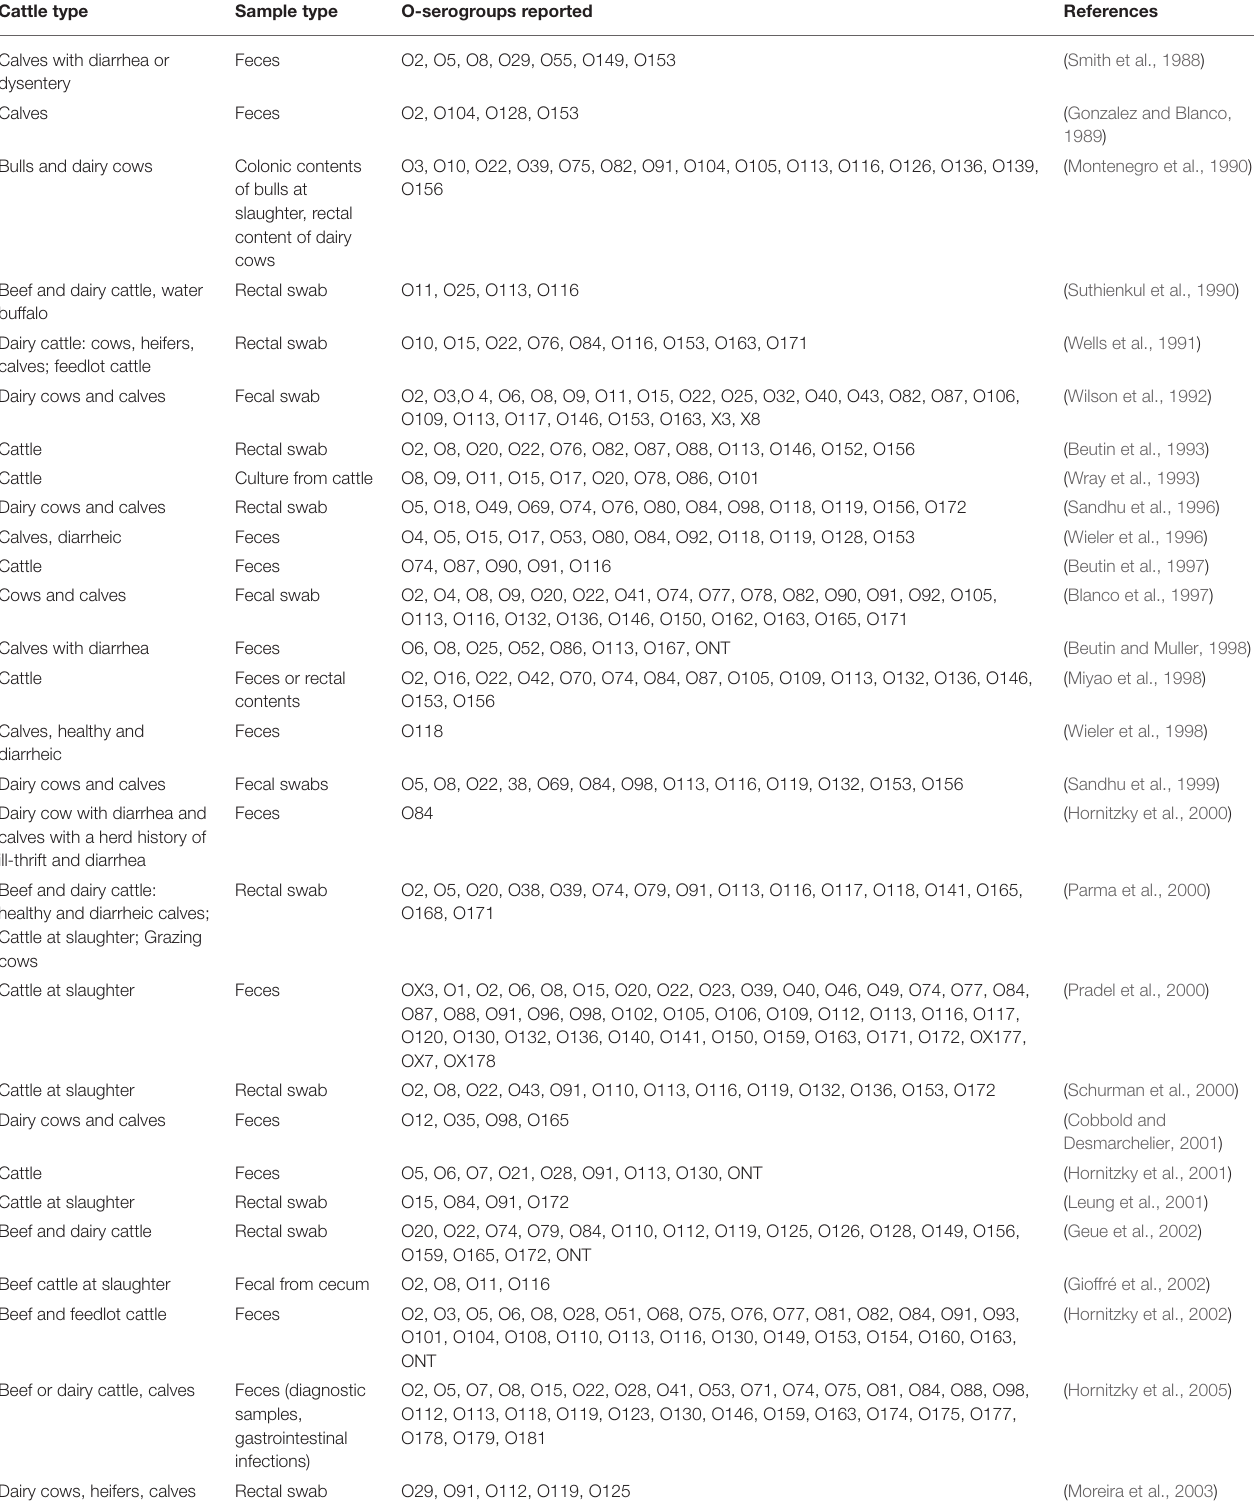
TABLE 2 | Serogroups of Shiga toxin-producing Escherichia coli other than the top-7 in gut contents or feces of